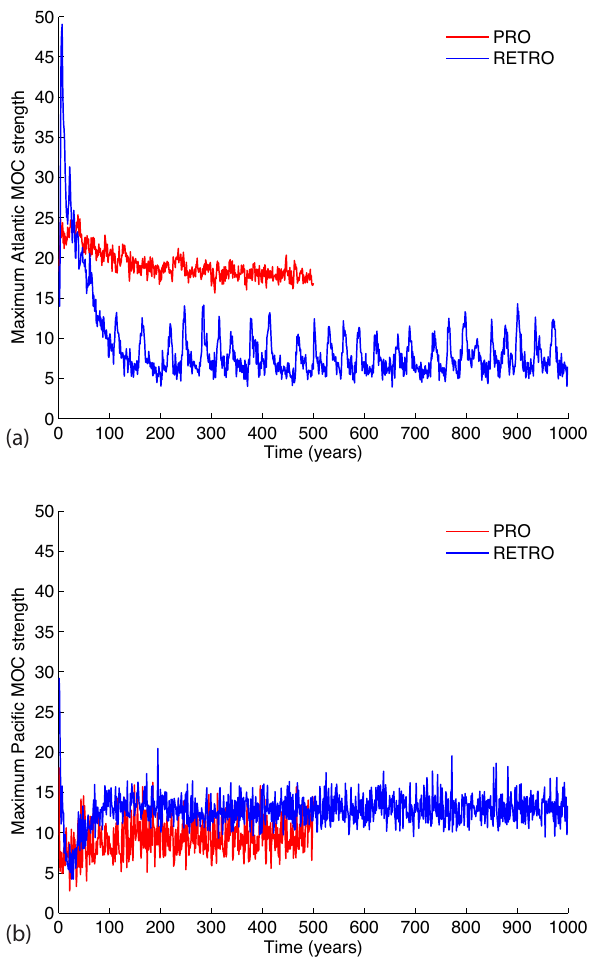
Fig. 2. Surface wind field (ms − 1 ) in (a) PRO and (b) RETRO. The Fig. 2. Surface wind field (m/s) in (a) PRO and (b) RETRO. The reversal of the surface wind direction in reversal of the surface wind direction in RETRO due to a reversal Fig. 1. The strength (in Sv) of the (a) maximum Atlantic and RETRO due to a reversal of the Coriolis parameter can be clearly seen. The equatorial trade winds are westward of the Coriolis parameter can be clearly seen. The equatorial trade (b) maximum Pacific meridional overturning circulation (below winds are westward and the midlatitude winds are eastward on a Fig. 1. The strength (in Sv) of the (a) maximum Atlantic and (b) maximum Pacific meridional overturning and the midlatitude winds are eastward on a retrograde rotating earth. The strongest winds still occur over the 500m) as a function of time (in years) for PRO (500 year sim- retrograde rotating earth. The strongest winds still occur over the ulation, red) and RETRO (1000 year simulation, blue). After circulation (below 500 m) as a function of time (in years) for PRO (500 year simulation, red) and RETRO Southern Ocean. Shown are the means of the years Southern Ocean. Shown are the means of the years 400–500. 500 years, the Atlantic MOC is in a quasi-stable equilibrium for (1000 year simulation, blue). After 500 years, the Atlantic MOC is in a quasi-stable equilibrium for both PRO both PRO and RETRO. and RETRO.